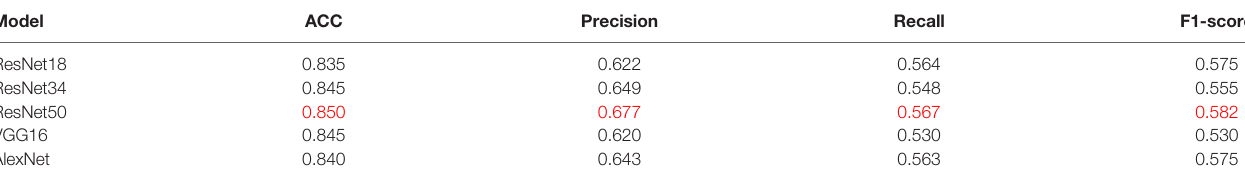
TABLE 3 | Comparison of performance of different models (TMB cutoff = 20).